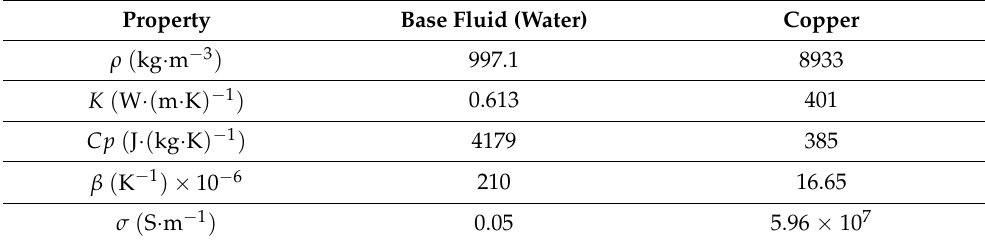
Table 1. Thermo-physical properties of copper and water [31,32].